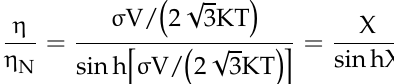
Figure 10. Master curve between normalized viscosity η/η N and X at different temperatures, where X= σV/(2√3KT) . The solid line is fitted by Equation (7).